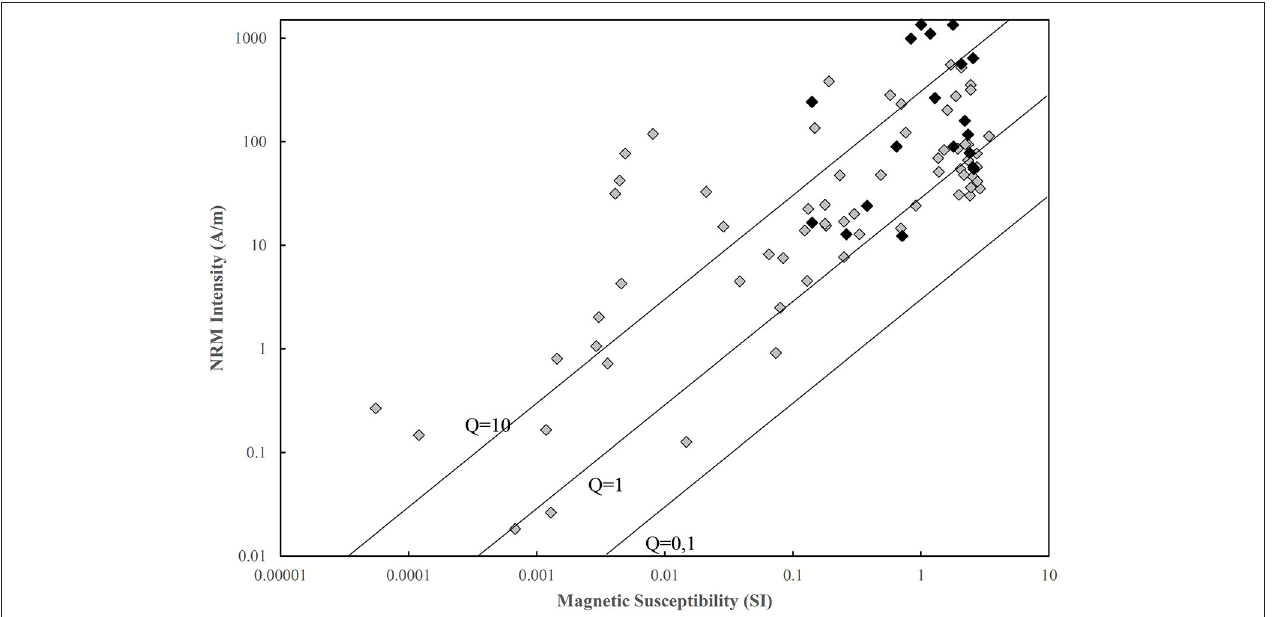
FIGURE 3 | NRM vs. Susceptibility plot representing values for the different samples from Mauritania. Each diamond corresponds to a core fragment: black ones were selected for magnetic mineralogy measurements. The black lines represent different values of Koenigsberger ratio (Q) with induced magnetization proportional to the chosen natural magnetic field reference value measured in Mauritania (36.34 µ T; Thébault et al., 2015).